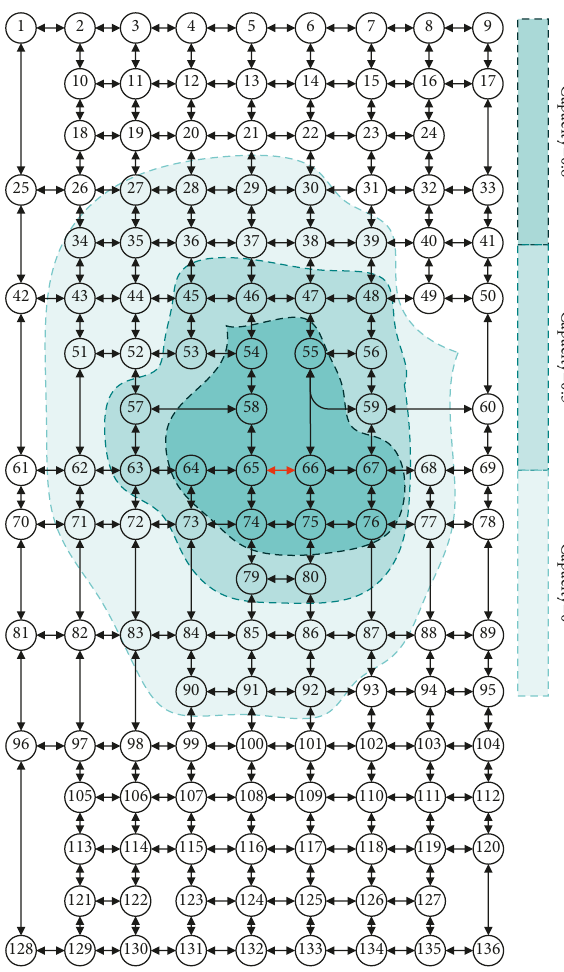
Figure 15: Subnetwork under different scenarios. Figure 14: Subnetwork under different